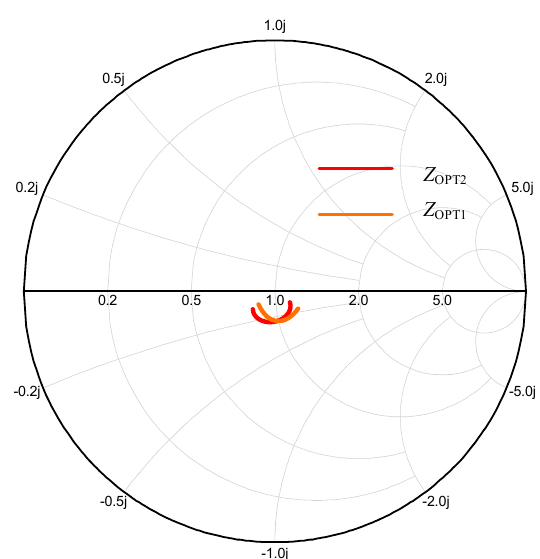
Figure 9. Simulated impedance Z OPT1 and Z OPT2 .